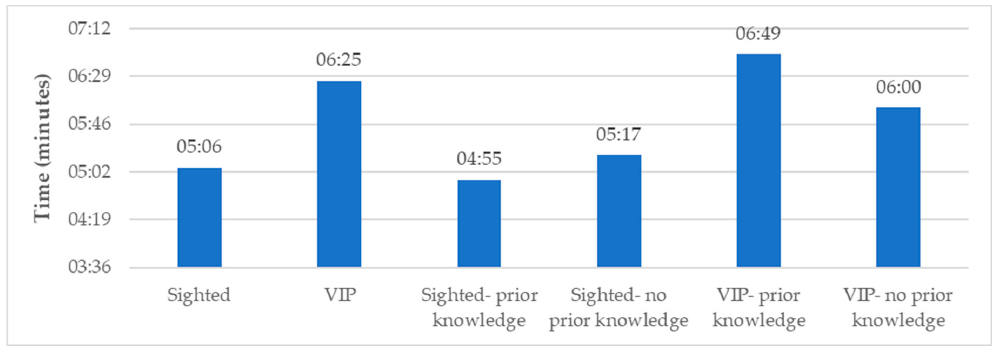
Figure 6. Efficiency in tactile model reading.